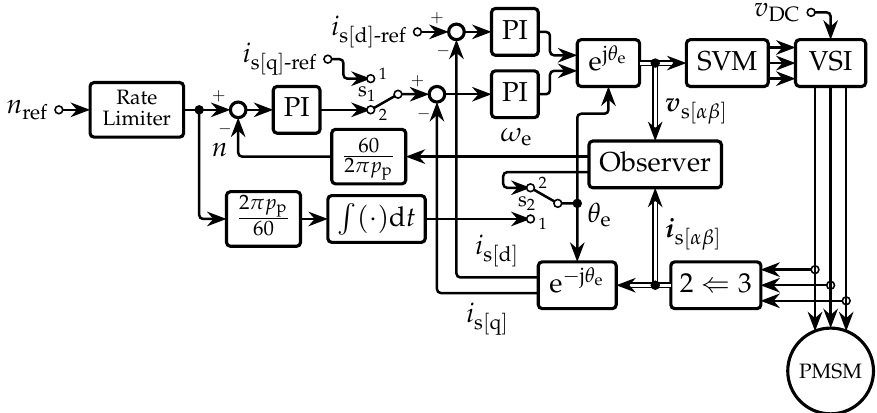
Figure 2. A simplified diagram of the sensorless FOC for